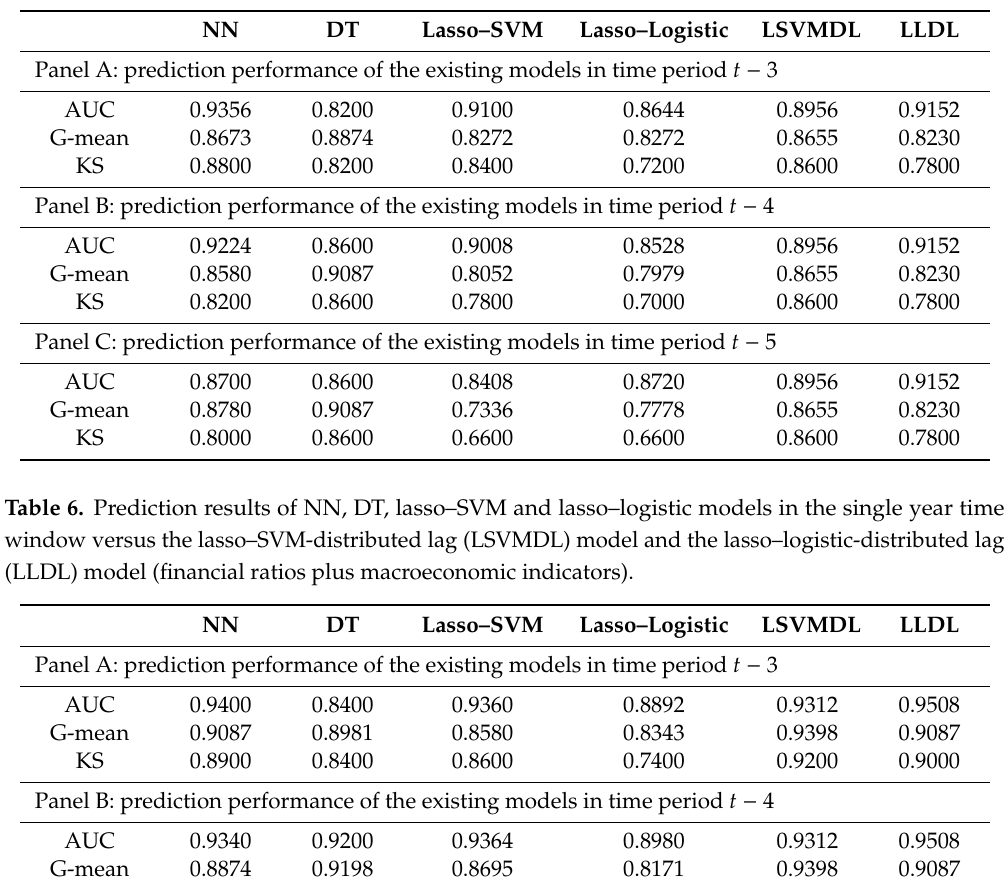
Table 5. Prediction results of the neural network (NN), decision tree (DT), lasso–SVM and lasso–logistic in the single year time window versus the lasso–SVM-distributed lag (LSVMDL) and lasso–logistic-distributed lag (LLDL) models (financial ratios only).